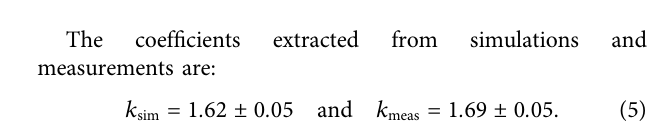
Frontiers in Physics |